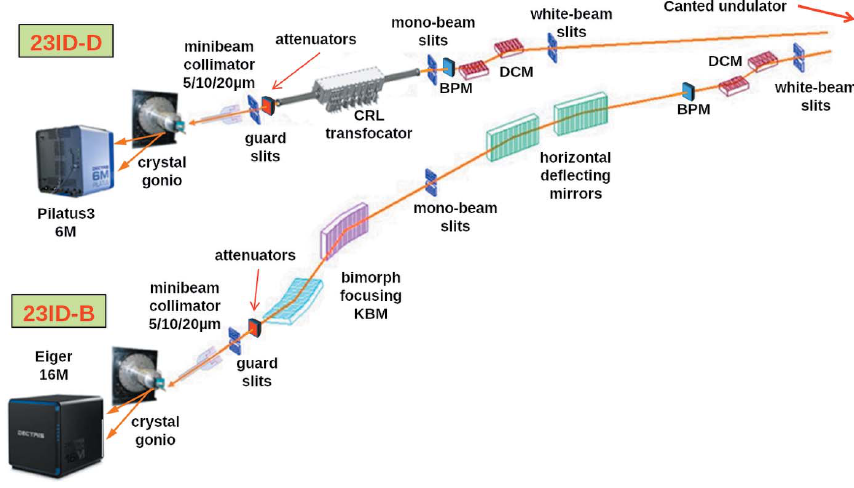
Figure 1 Layout of the GM/CA canted undulator beamlines at the APS. DCM, double-crystal monochromator; BPM, beam position monitor used in maximizing beam flux (intensity feedback); CRL, compound refractive lens; and KBM, Kirkpatrick–Baez mirrors.